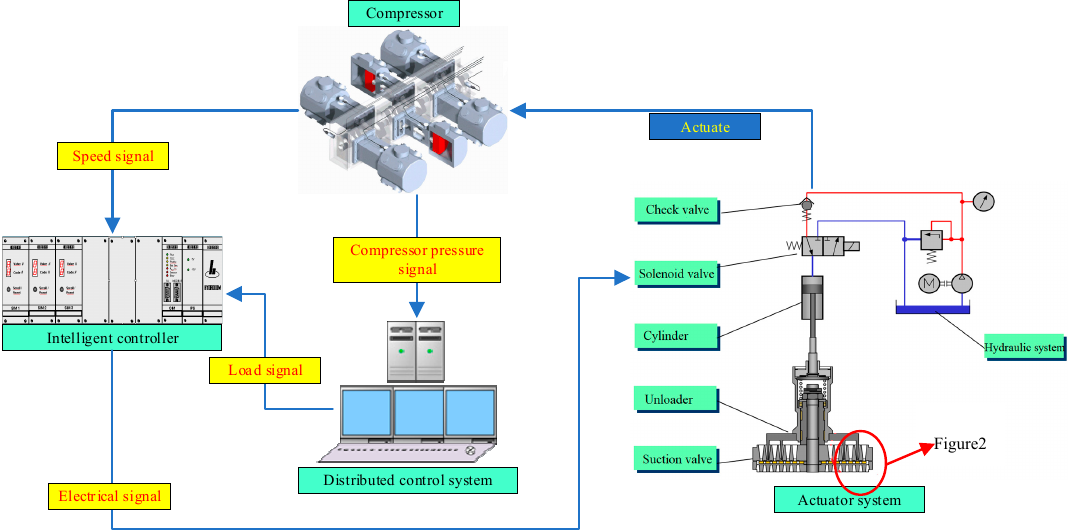
Figure 1. Composition of stepless capacity control system.